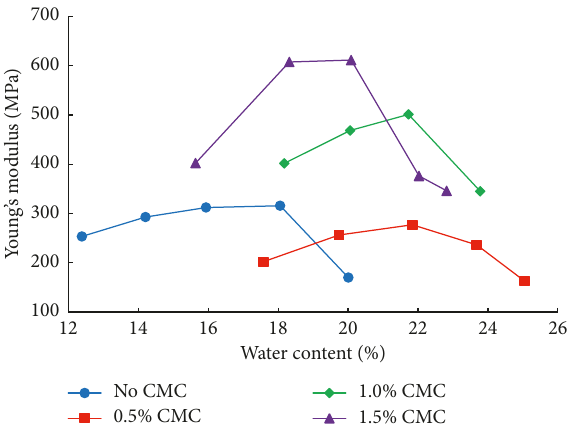
Figure 7: Moisture- E s relation for CMC-stabilized